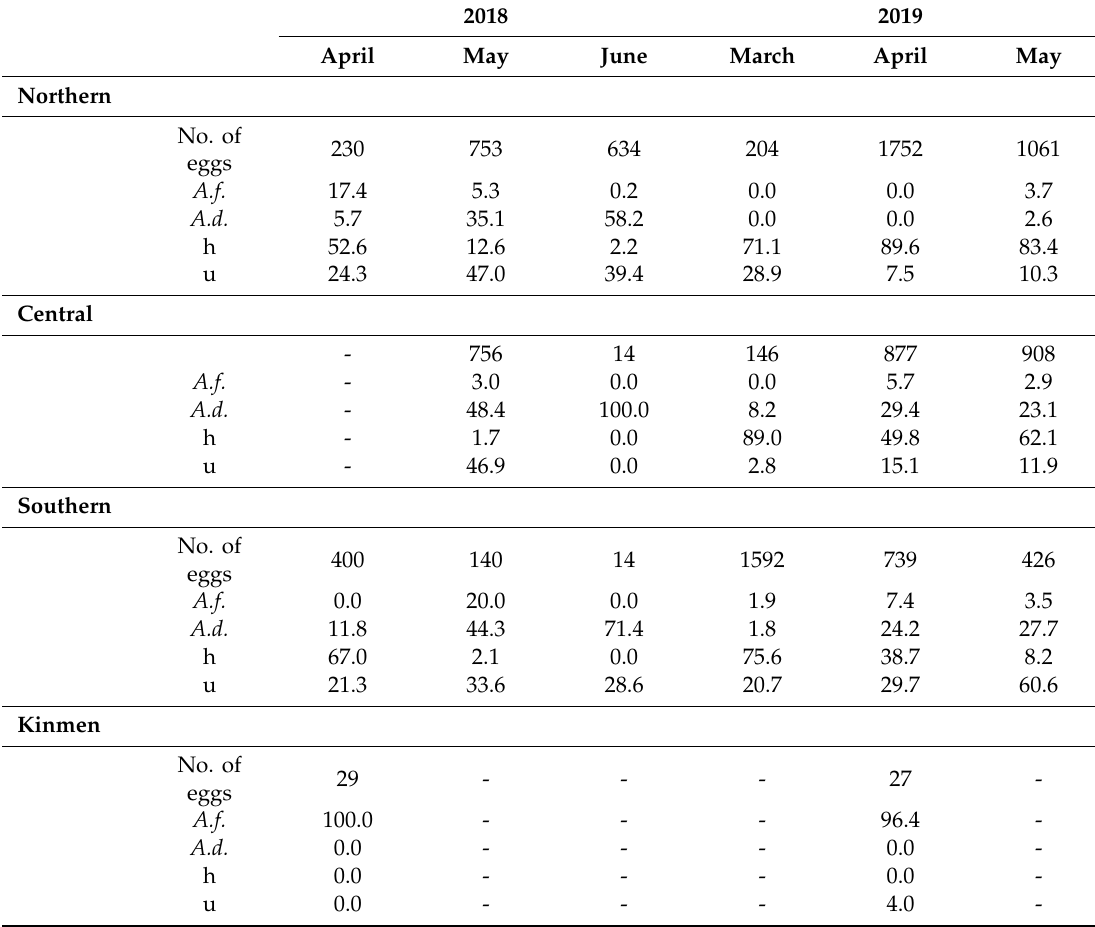
Table 1. Percentages of parasitized by each of the two major egg parasitoid species (parasitoid impact), hatched and unhatched eggs in the main island of Taiwan (northern, central, and southern) and